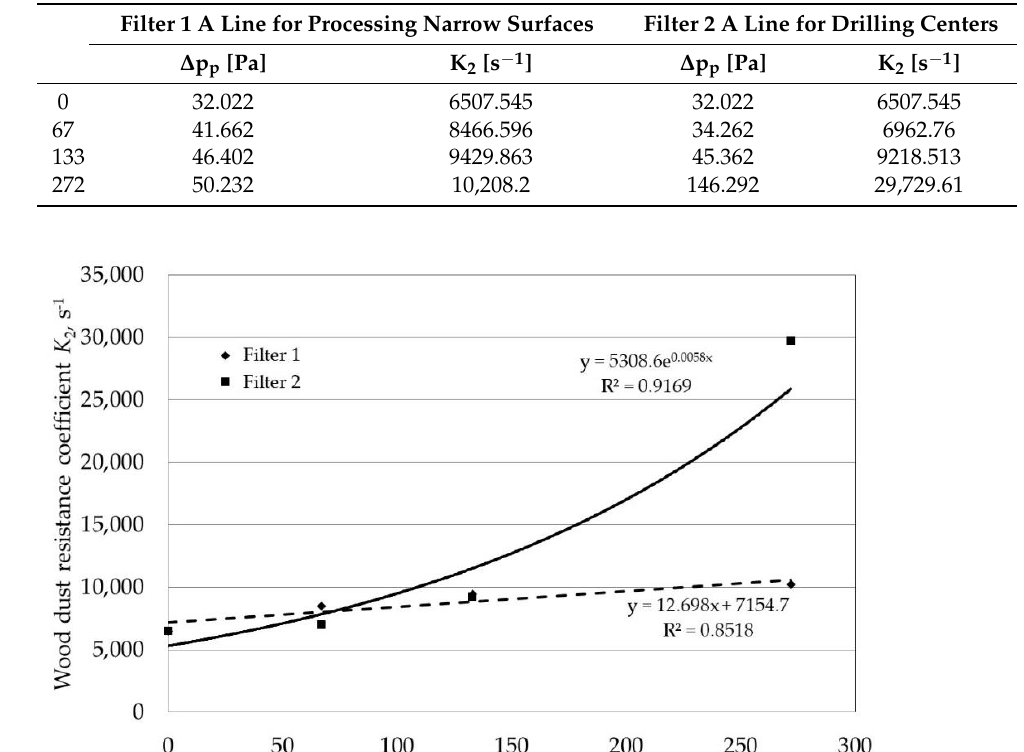
Table 6. Summary of the resistance values ∆ p p and the K 2 coefficient for individual test variants.